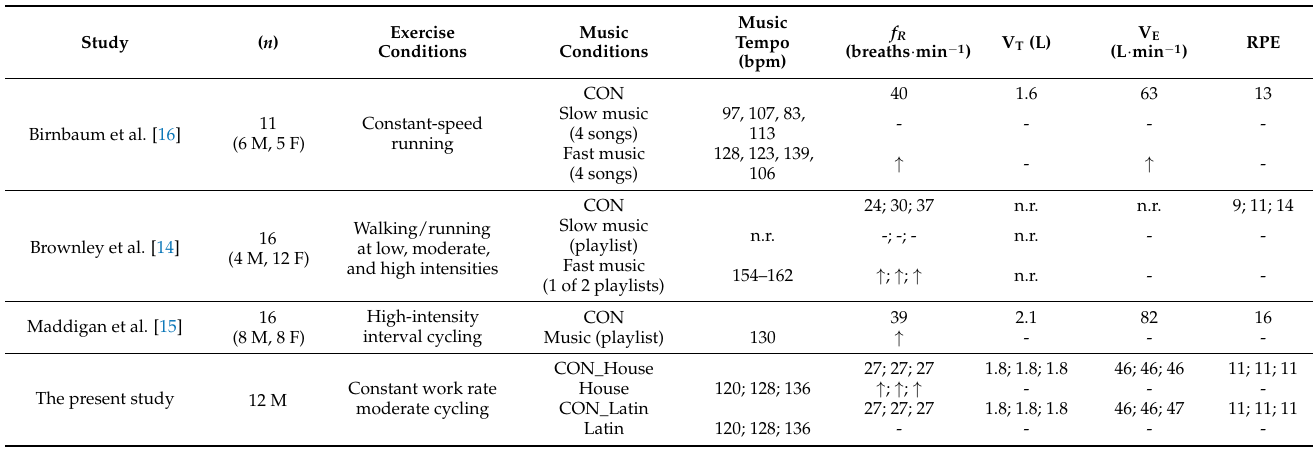
Table 1. Comparison between the present study and previous studies investigating the effect of music on breathing during exercise.